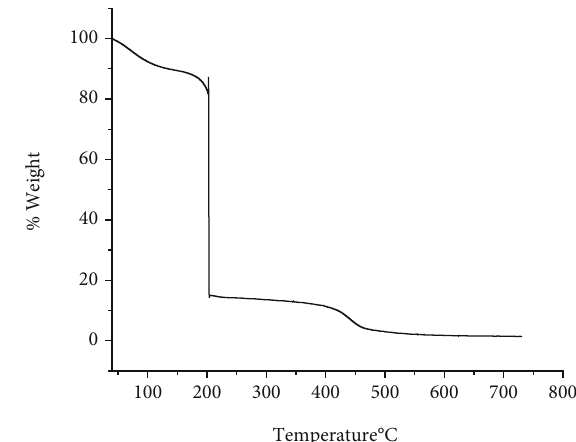
Figure 7: TGA spectrum of as synthesized GFT oxide nanocomposite.